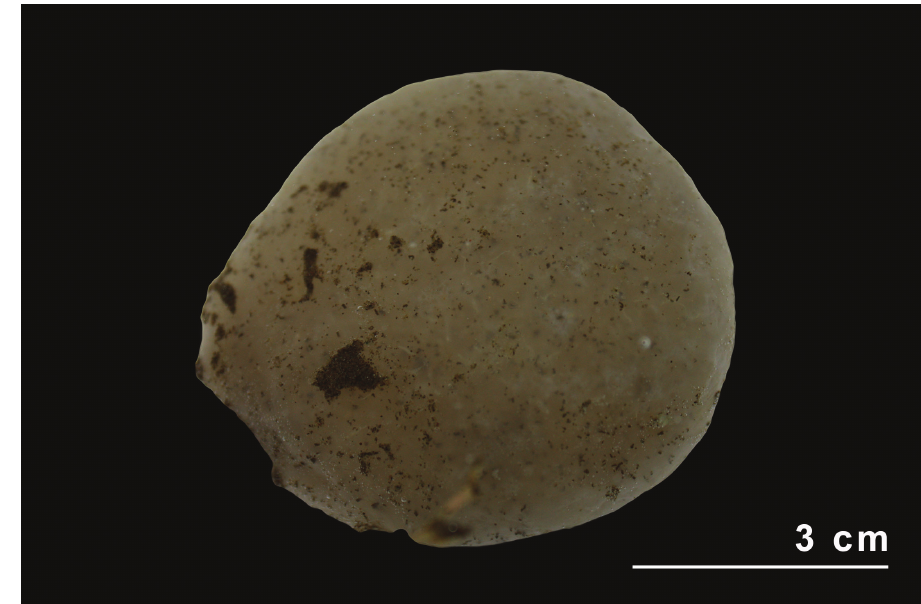
Figure 2 . Colony of Synoicum molle photographed in vivo.